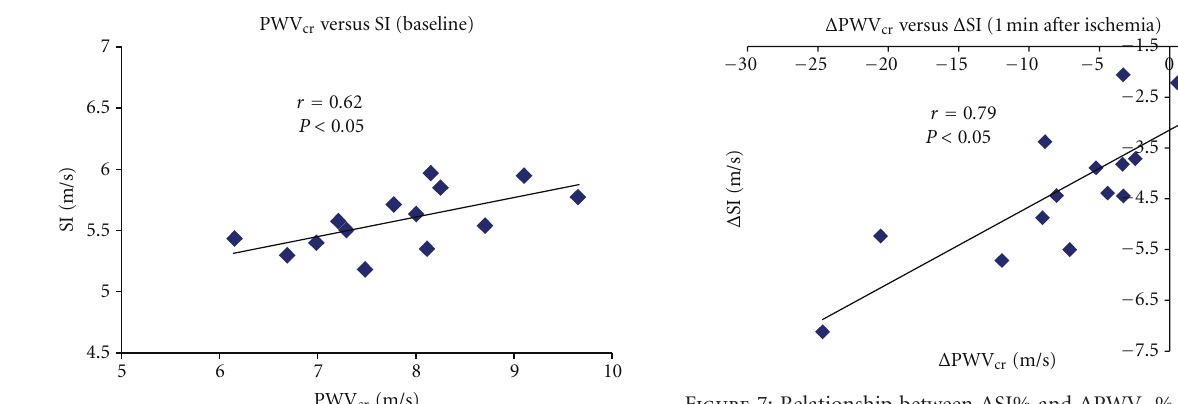
Figure 7: Relationship between Δ SI% and Δ PWV cr % one minute after